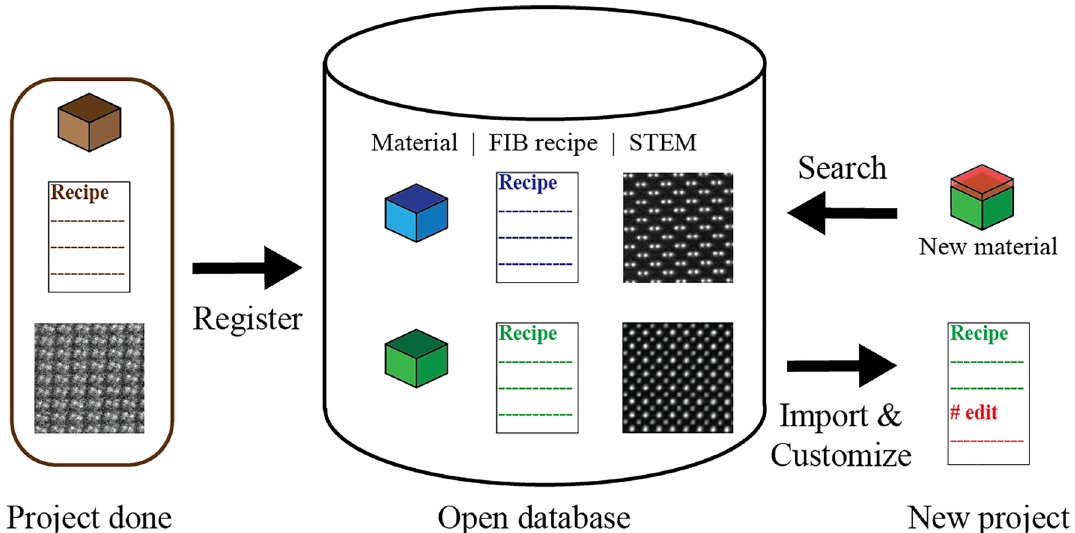
Figure 8. A conceptual schematic of an open database of FIB recipes. An open database stores data of material information (e.g., compositions), the digitalized recipe of the robotic FIB, and its STEM results. Any user can register new results. According to the material information, any user can search and import an FIB recipe that is suitable for the targeted material from the database. The user can further adjust the FIB recipe for the targeted material. Hence, the open database accelerates exchanging the knowledge of FIB in the whole community of materials